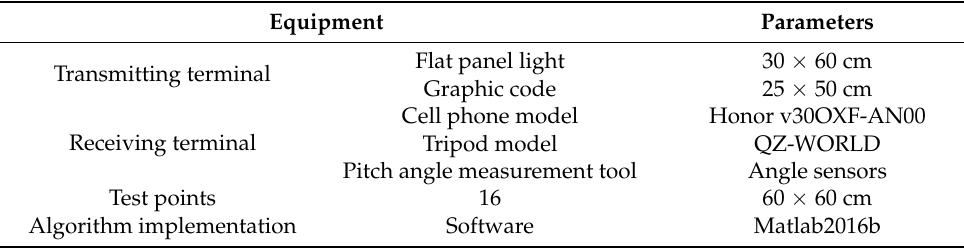
Table 2. Parameter settings for test